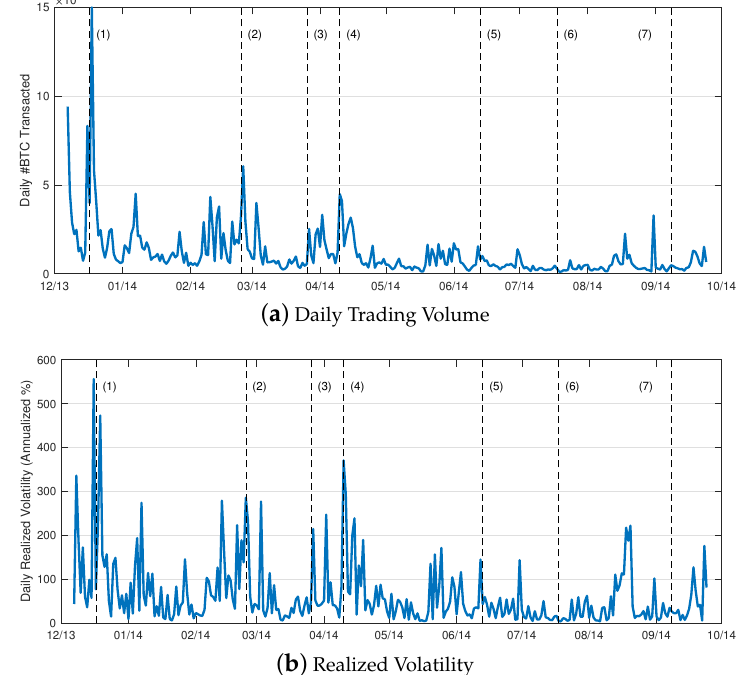
Figure 3. Daily trading activity and realized volatility. Realized volatility is computed from √ 5-min returns, and annualized by a factor of 365. Data are from the BTC-e platform for the period from 7 December 2013 to 24 September 2014. Vertical lines mark the following dates: (1) 17 December 2013: third-party payment firms cut off services to bitcoin exchanges in China; (2) 24 February 2014: Mt. Gox exchange collapsed; (3) 25 March 2014: the IRS declared bitcoin to be taxed as property; (4) 10 April 2014: bank accounts of Chinese bitcoin exchanges were closed; (5) 13 June 2014: Mining pool GHash.io reached 51% harshing power; (6) 18 July 2014: Dell started accepting bitcoin; and (7) 8 September 2014: Paypal subsidiary Braintree started accepting